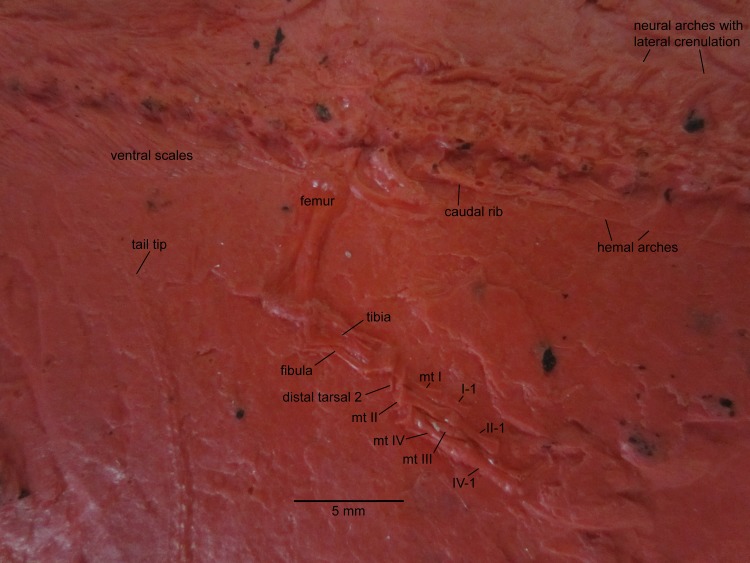
Area around the right hindlimb of a latex cast of the Sauropleura specimen shown in Fig. 31.Abbreviation: mt, metatarsal. Photo taken by D. M.